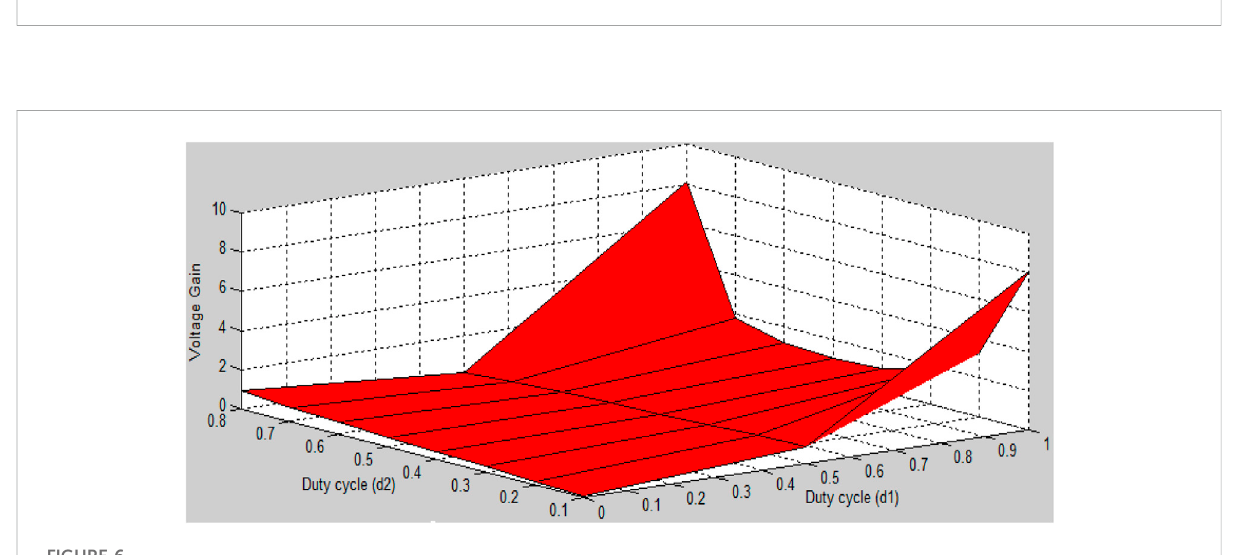
FIGURE 6 Voltage conversion